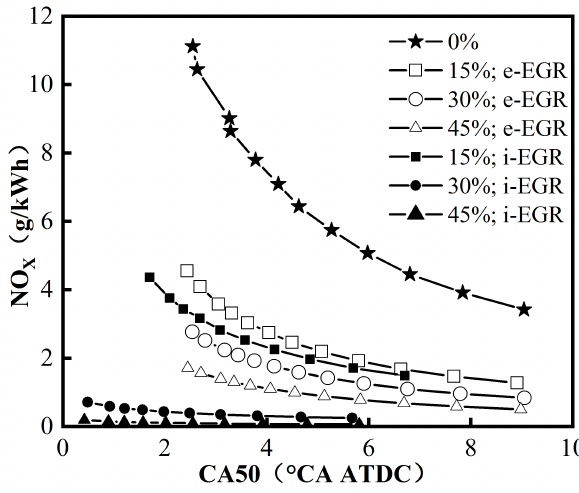
Fig. 9 Effects of CA50 and EGR ratio on NO X